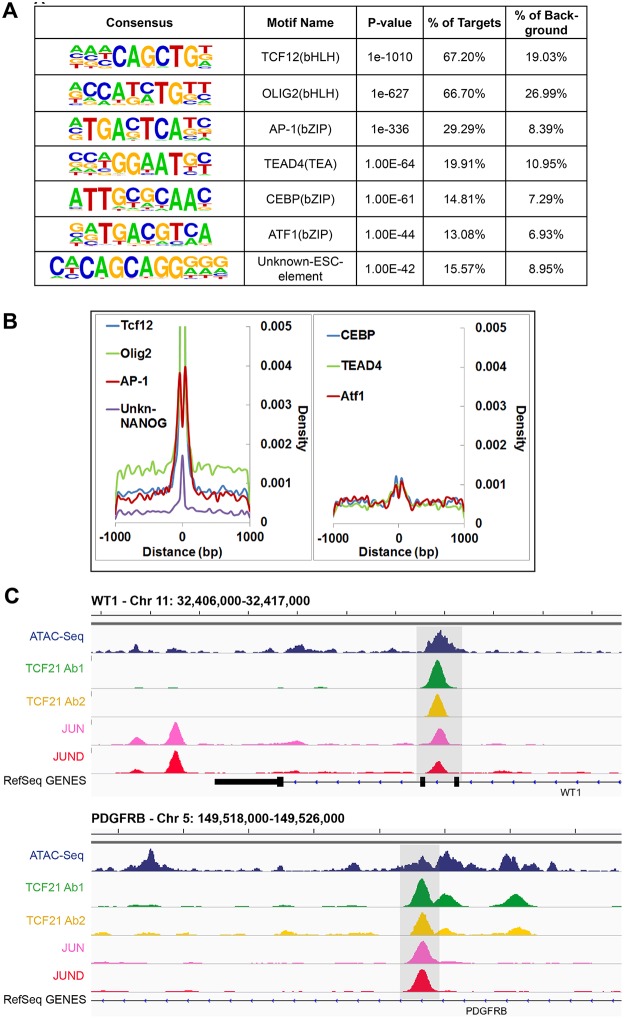
Analysis of peak sequences identifies TCF21 binding motifs as well as motifs for JUN related and other transcription factors that likely cooperate with TCF21.A) HOMER analysis of known TF motif enrichment within TCF21 peaks in the Ab_Shared data revealed several distinct motif families. The bHLH motif CAGCTG is identical to that attributed to TCF12, a known heterodimer partner of TCF21 [26], and a second highly enriched bHLH motif CATCTG is attributed to nervous system TF OLIG2, suggesting that TCF21 can bind either of these two motifs. The bZIP motif TGA(G/C)TCA most closely resembles the binding sequence for TFs within the AP-1/ATF super family. Other motifs found to be enriched in the TCF21 peaks include those mediating binding of TEAD, CEBP, and ATF transcription factor family members, and an unknown element identified by ChIP-Seq with NANOG in human embryonic stem cells (ESC). B) Distribution (density) plots for top 7 motifs from panel A: TCF12, OLIG2, AP-1, unknown-NANOG (left), and CEBP, TEAD4, ATF1 (right). C) TCF21 binds in close proximity to JUN and JUND in a number of loci, including developmentally important WT1 and PDGFRB loci.